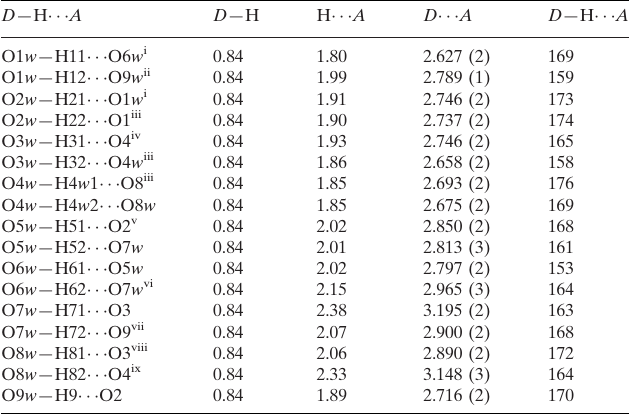
Hydrogen-bond geometry (A˚ , (cid:3)